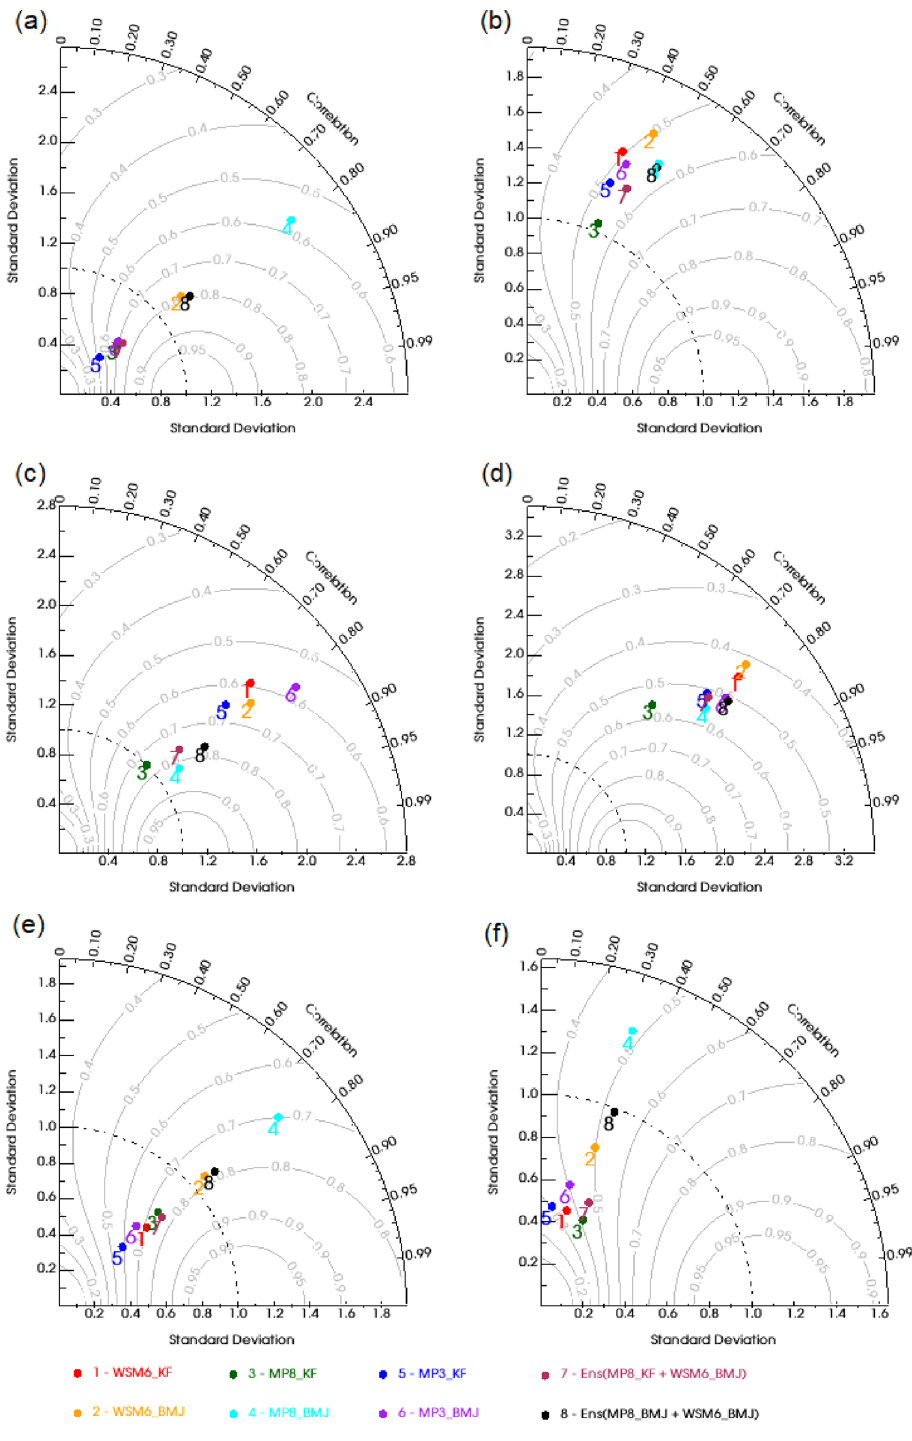
Figure 7. Taylor plots using spatial ( a , c , e ) and temporal correlation ( b , d , f ) between WRF experiments (WSM6_KF, WSM6_BMJ, MP8_KF, MP8_BMJ, MP3_KF, and MP3_BMJ) and Aphrodite precipitation for 2003. Taylor plots are showing correlation, normalized standard deviation, and contours as skill score for ANN ( a , b ), DJF ( c , d ), and JJAS ( e , f